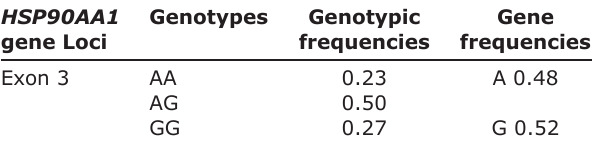
Table-2: Gene and genotypic frequencies of the patterns/variants in Sahiwal cattle population.